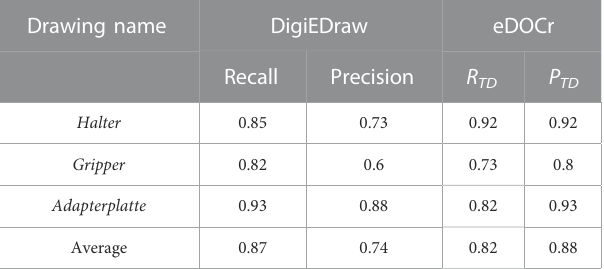
TABLE 4 Comparison between the DigiEDraw and eDOCr tools. A comparison between html scrapping and clustering technique against production drawings supported OCR